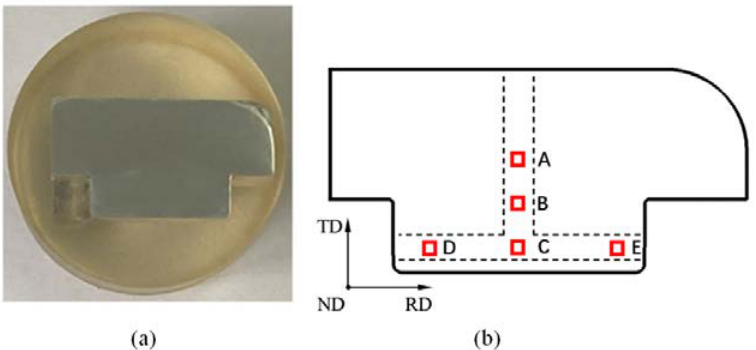
Figure 16. Samples in cross section of boss at blank length of 60 mm and observation position: ( a ) boss cross section sample and ( b ) sample observation positions.